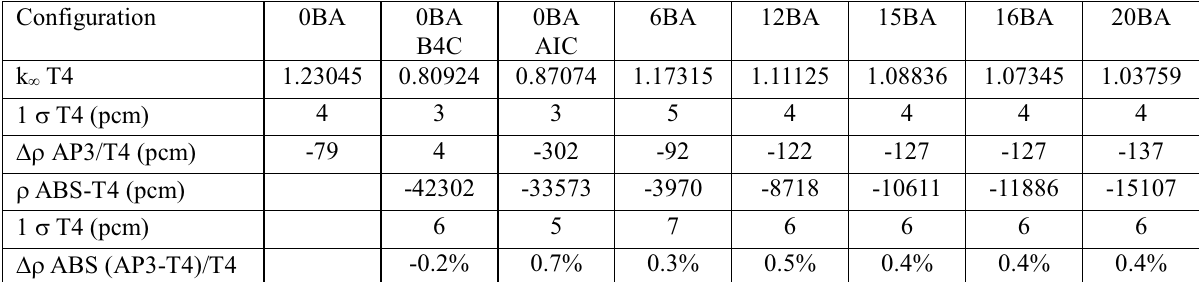
Table II. BEAVRS 3.1 enriched assembly: and reactivity worth comparisons. APOLLO3 ® /TRIPOLI-4 ® k ∞